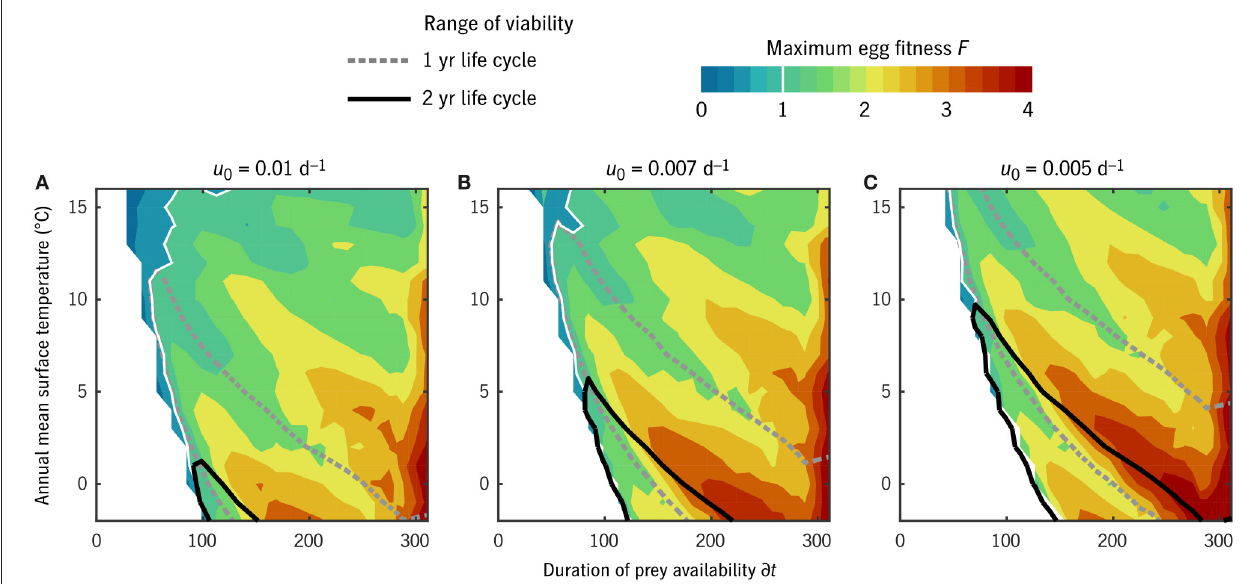
FIGURE 5 | Maximum egg fitness (eggs per starting egg per generation) across all combinations of temperature and duration of prey availability in the “global” experiment. Unfilled contour lines give the environmental range over which 1-year (gray, dotted) and 2-year (black, solid) life cycles are viable. The white regions at low prey availability indicate environments in which no timing strategy exists that allows successful maturation. (A–C) Give results for three values of u 0 corresponding to the families of cases shown in Figure 4 .